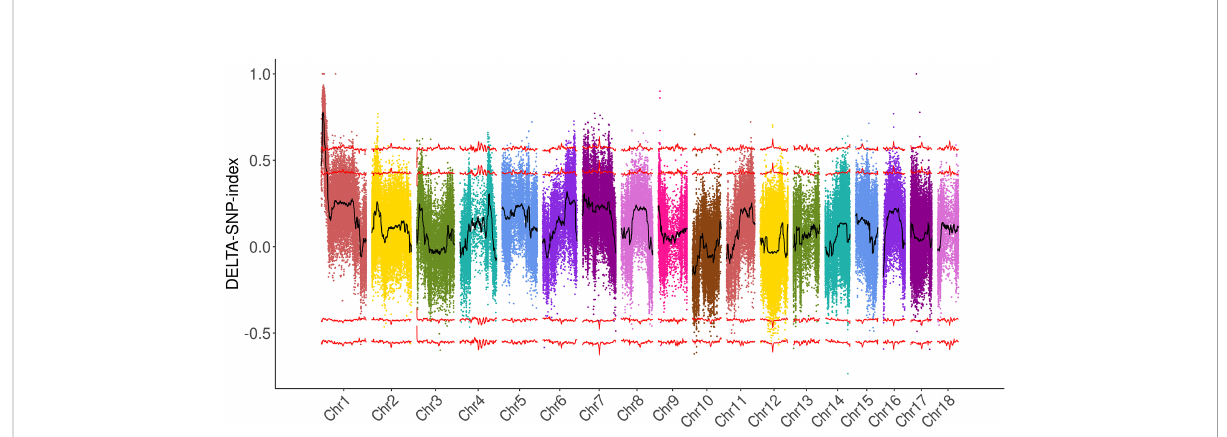
FIGURE 2 Mapping of a locus controlling plant height in broomcorn millet using the D SNP index with the bulked segregant analysis (BSA) strategy.